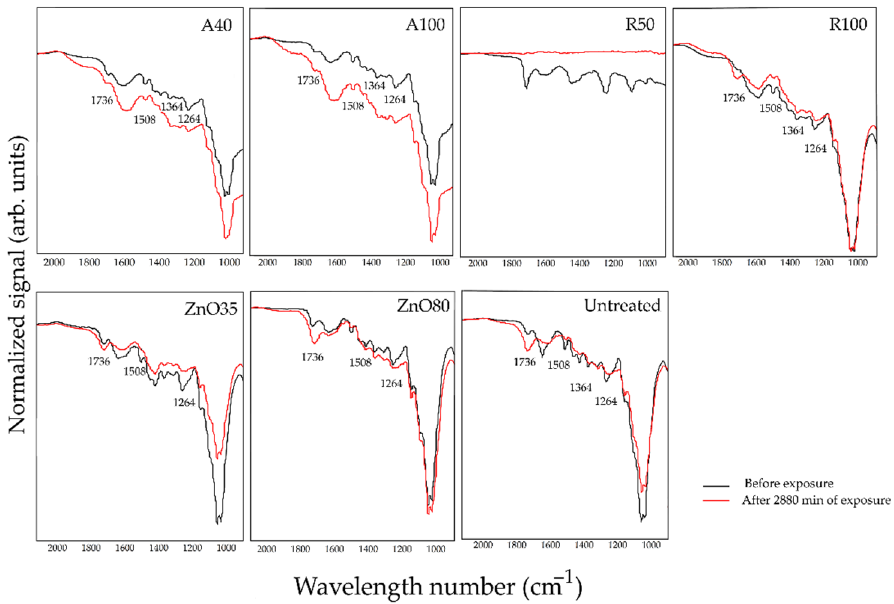
Figure 5. FTIR-ATR spectra of wood samples treated with anatase 40 nm (A40), anatase 100 nm (A100), rutile 50 nm (R50), rutile 100 nm (R100), ZnO 35–45 nm (ZnO35), ZnO 80–200 nm (ZnO80), and untreated samples (control); before and after 2880 min of UV exposure (340 nm), except R50, for whose spectra were obtained after 120 min of exposure.